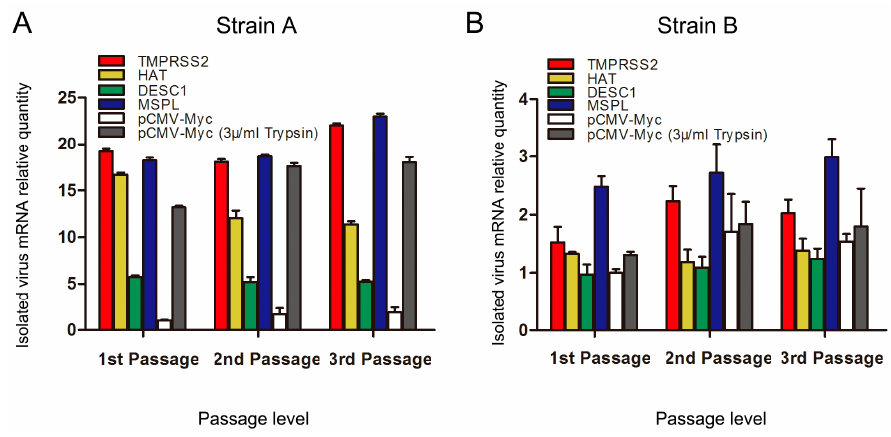
Figure 7. Culture of PEDV isolated from pig intestine in Vero cells transiently expressing TTSPs in three serial passages. ( A ) Isolation of PEDV strain A; ( B ) Isolation of PEDV strain B. The relative quantity of pCMV-Myc without trypsin at the 1st passage = 1. Error bars indicate standard error of the mean. Results shown are those of a representative experiment performed with triplicate samples.